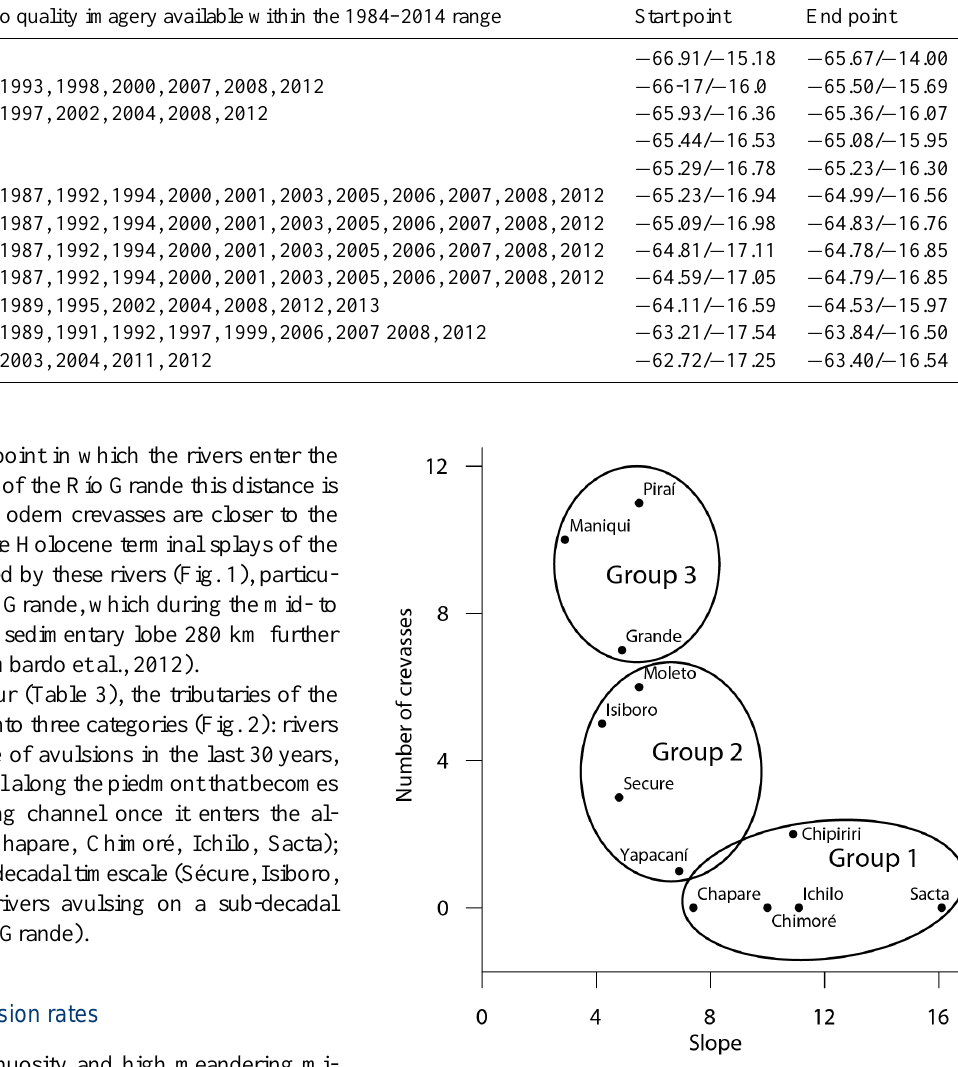
Figure 2. Number of crevasses detected since 1984 plotted against average river slope (see Table 3). Crevasses open up when the slope falls below 7.5